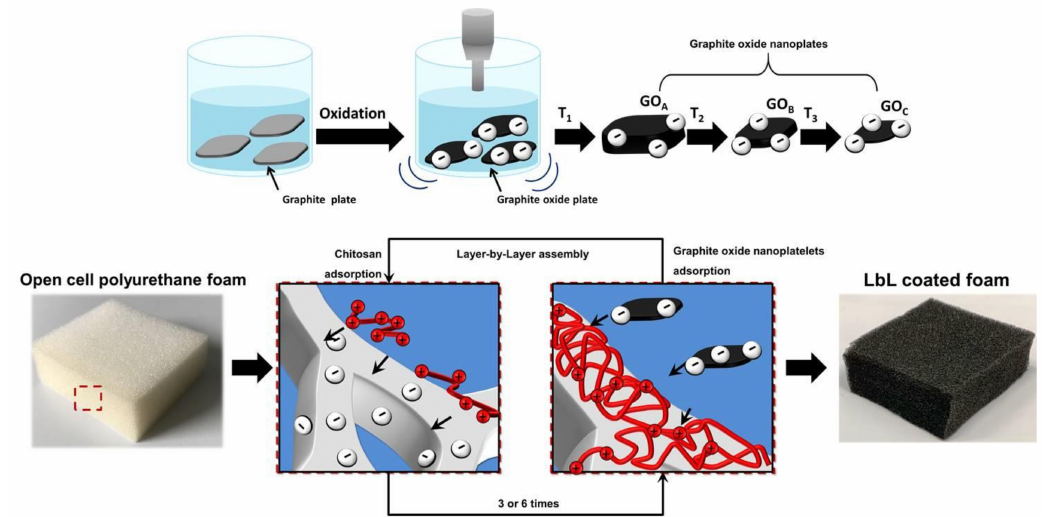
Figure 1. Schematic representations of the preparation process of graphite oxide nanoplates with different sizes and the subsequent layer-by-layer (LbL) assembly on polyurethane (PU)